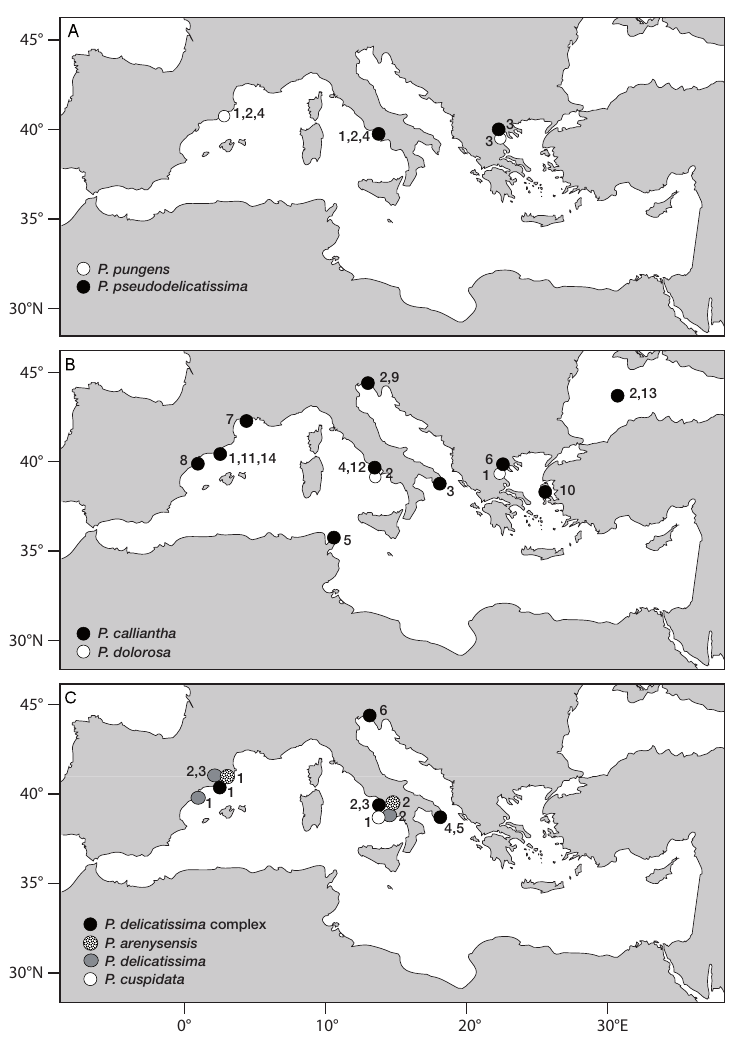
Fig . 6. – Geographic distribution of Pseudo-nitzschia in the Mediterranean Sea. See Table 6 for references and information of each